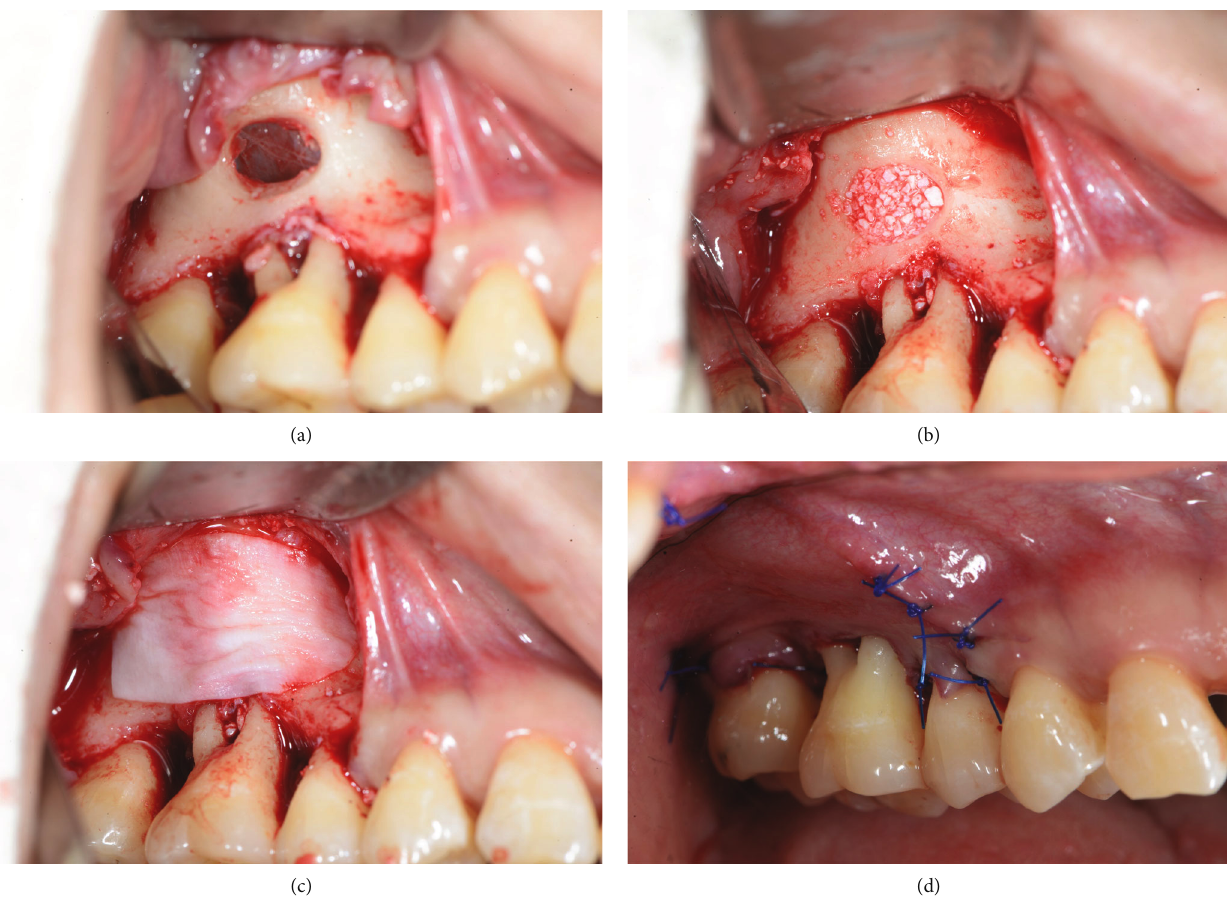
Figure 4: The process of the modi fi ed lateral sinus fl oor elevation. (a) Access window on the lateral wall. (b) Grafting materials at the sinus fl oor. (c) Collagen membrane covering access window. (d)